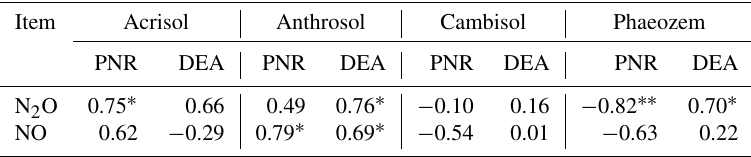
Data shown are means ± SD of the three replicates. See Fig. 1 for treatment codes. Different lowercase letters within the same column indicate significant differences among treatments within the same soil at p< 0 . 05 level. Different capital letters within the same row indicate significant differences among soil types within the same treatment at p< 0 . 05 level. Table 4. The correlations between N 2 O or NO emission and PNR or DEA in each